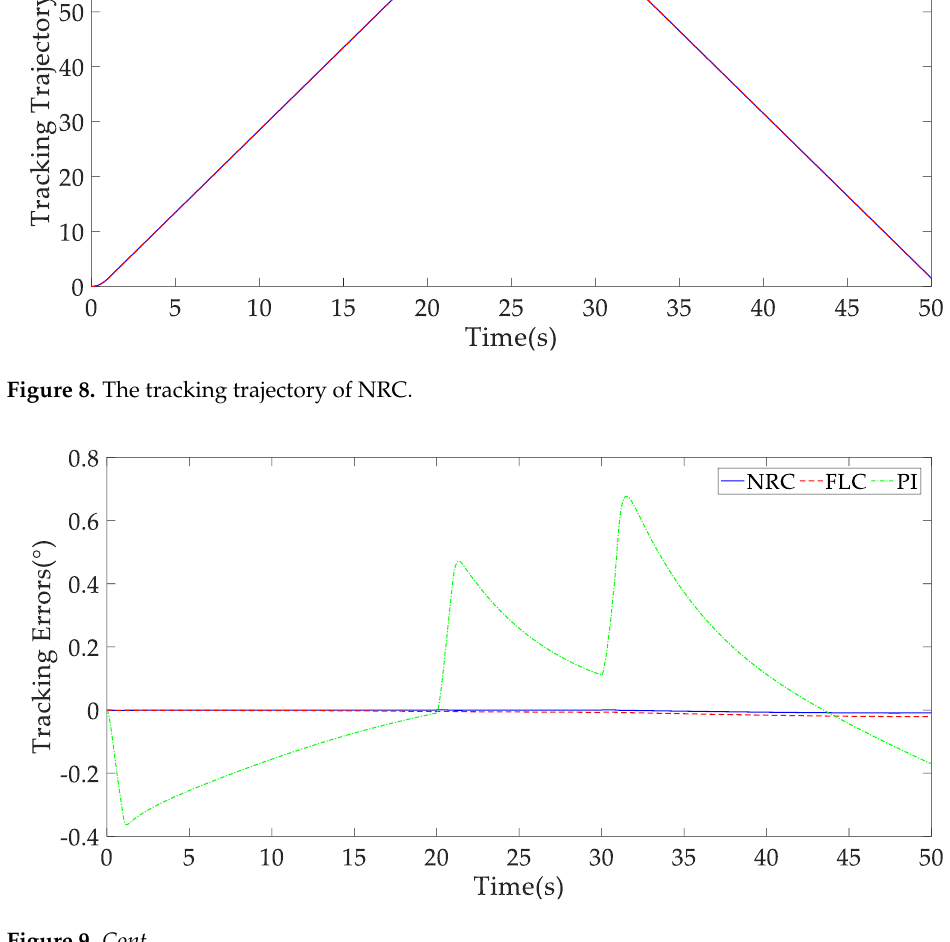
Figure 9. The tracking errors of three controllers.